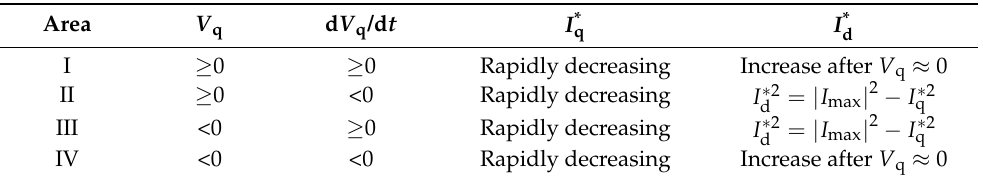
Table 1. Adjustment strategy for the current reference after fault clearing.